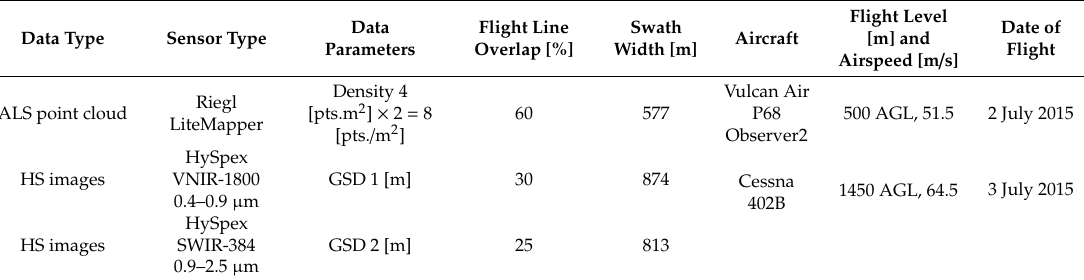
Table 1. Multiple flights data fusion—fusion of data collected with di ff erent sensors in multiple flights. Abbreviations: HS—Hyperspectral; ALS—Aerial Laser Scanning; VNIR—Visual-Near